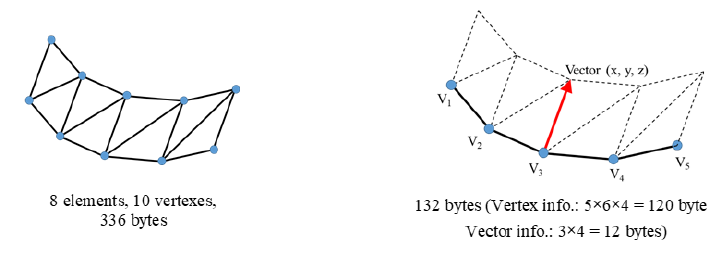
Figure 12. Data size minimization for mirroring type face.